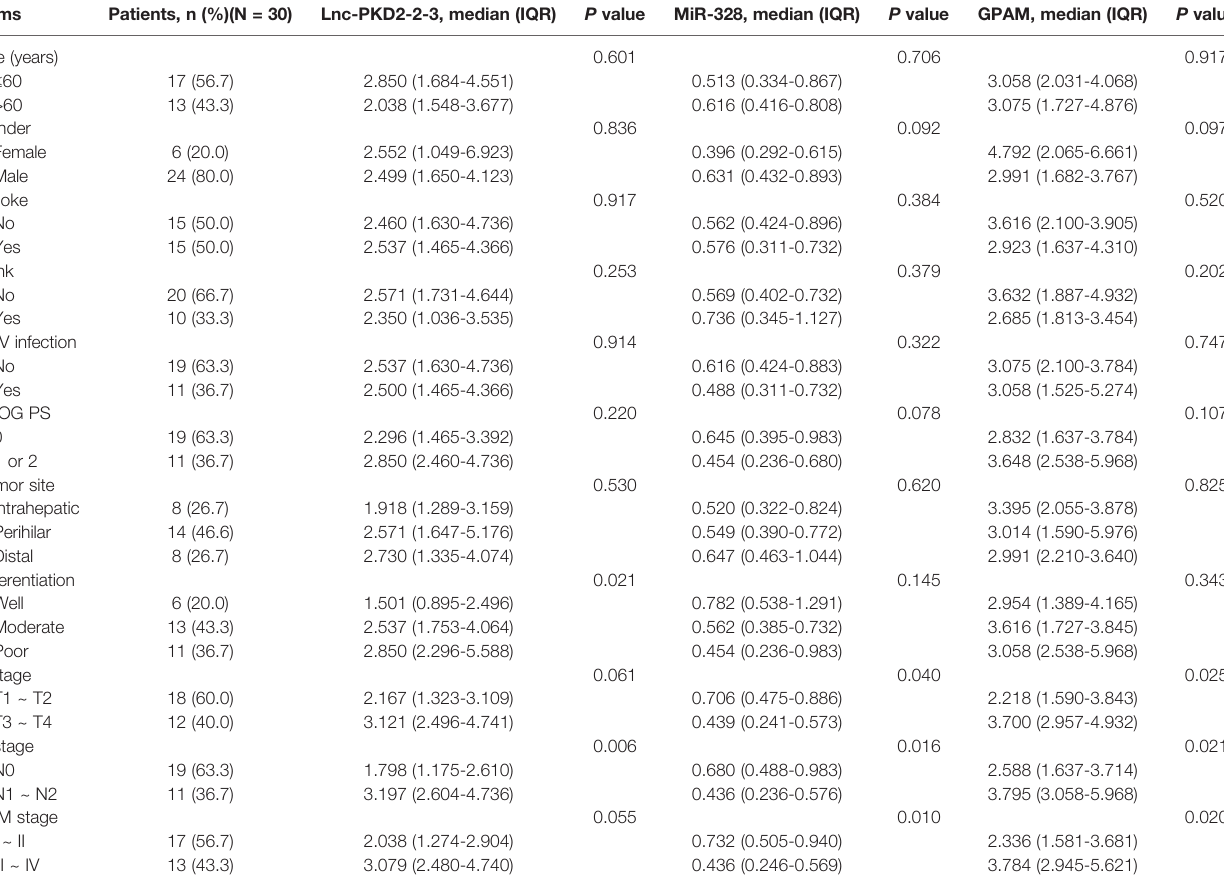
TABLE 1 | Correlation of lnc-PKD2-2-3, miR-328 and GPAM with clinical features of CCA patients. Items Patients, n (%)(N =